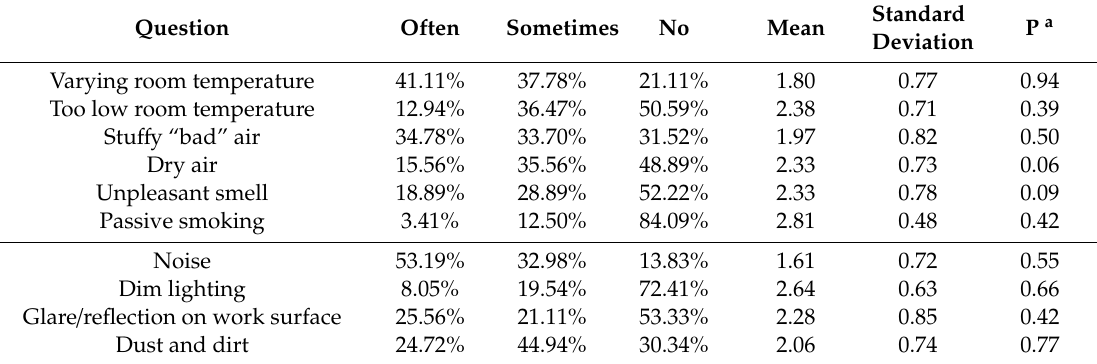
Table 3. User perception of room temperature, noise and lighting.